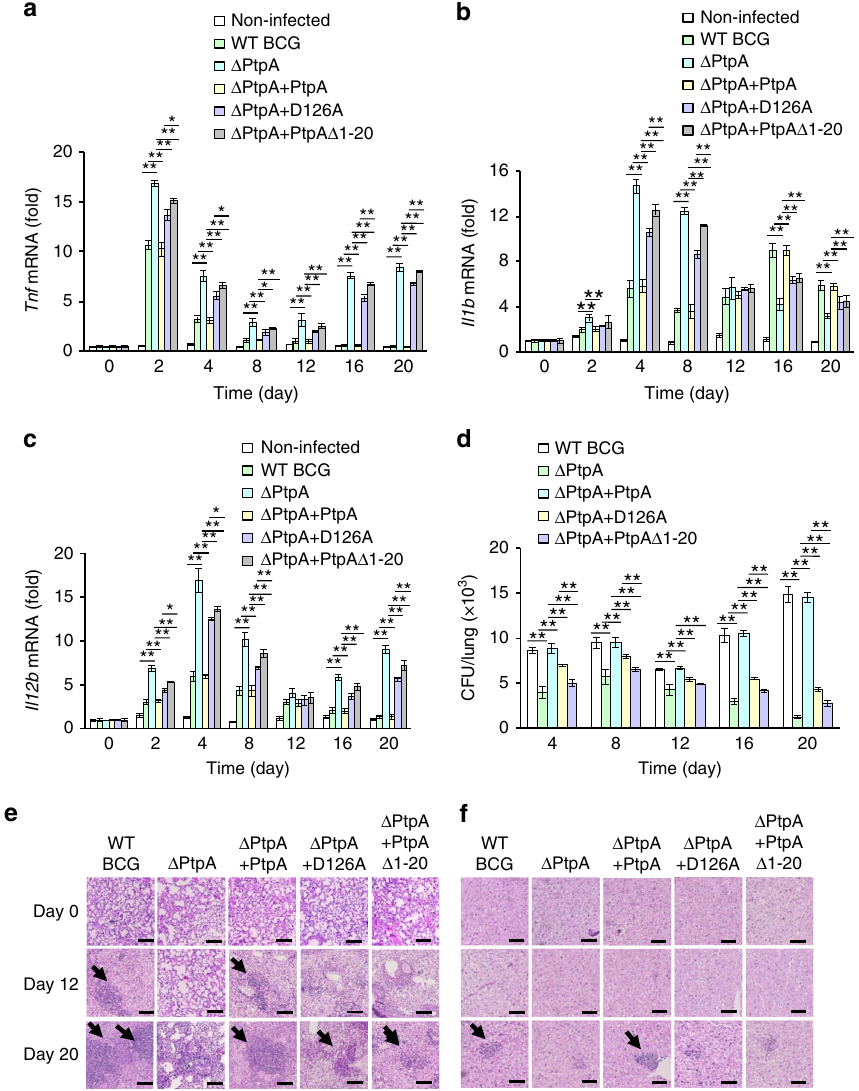
Fig. 8 Phosphatase activity and DNA-binding ability of PtpA contribute to innate immune suppression during infection in vivo. a – c Quantitative PCR analysis of Tnf mRNA a , Il1b mRNA b and Il12b mRNA c in splenic cells from mice. BALB/c nude mice were infected intratracheally with 2 × 10 6 of WT BCG, BCG Δ PtpA, BCG ( Δ PtpA + PtpA), BCG ( Δ PtpA + D126A), or BCG ( Δ PtpA + PtpA Δ 1-20) strain for 0 – 20 days. d Bacterial load in homogenates of lungs from mice treated as in a – c . e , f Hematoxylin and eosin (H&E) staining of lungs e and livers f of mice treated as in a – c . Arrows indicate foci of cellular in fi ltration. Scale bars , 200 μ m. * P < 0.05 and ** P < 0.01 (unpaired two-tailed Student ’ s t -test). Data are representative of one experiment with two independent biological replicates ( a – d ; mean and s.e.m. of n = 6 mice per